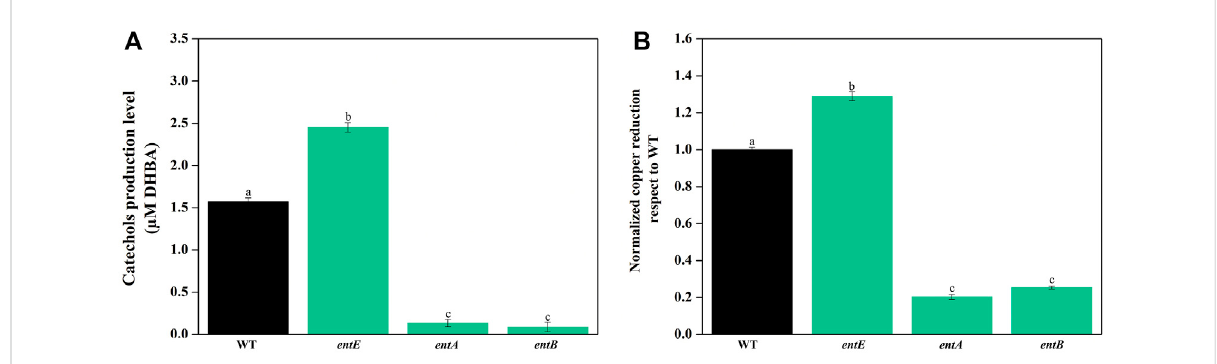
FIGURE 2 (A) Catecholcontentinsupernatantsof E.coli wild-typeandmutantsintheenterobactinsystem.Quantitationofcatechollevelswasperformed using Arnow method with fi lter-sterilized supernatants obtained from wild-type (WT) and mutant strains impaired in enterobactin synthesis ( entE, entA , and entB ). Results are expressed as μ M equivalents by comparison to a standard curve prepared using DHBA. Values are means ± SD for three independent experiments. (B) In vitro copper reducing power of supernatants of E. coli wild-type and mutants in the enterobactin system. Copper reducing activity was measured using bathocuproine disulfonate (BCDS). Values, normalized to Cu + in WT supernatant, are the means ± SD of three independent experiments. Statistically signi fi cant differences between any two conditions compared are indicated with different letters ( p < 0.05). Same letters indicate no statistically signi fi cant difference.